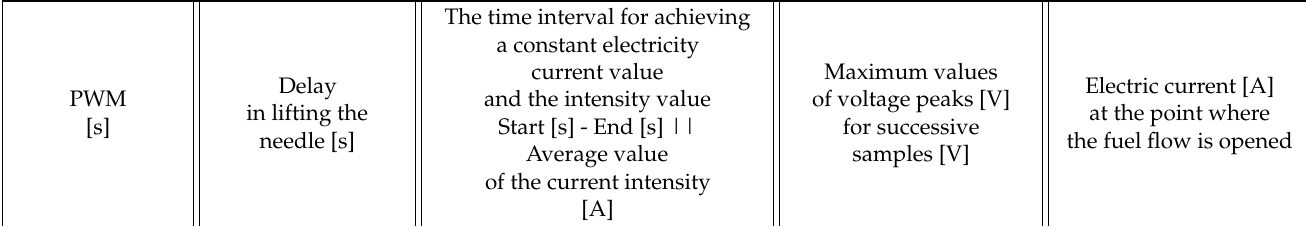
Figure 8. Final part of the search for the needle lifting phase.